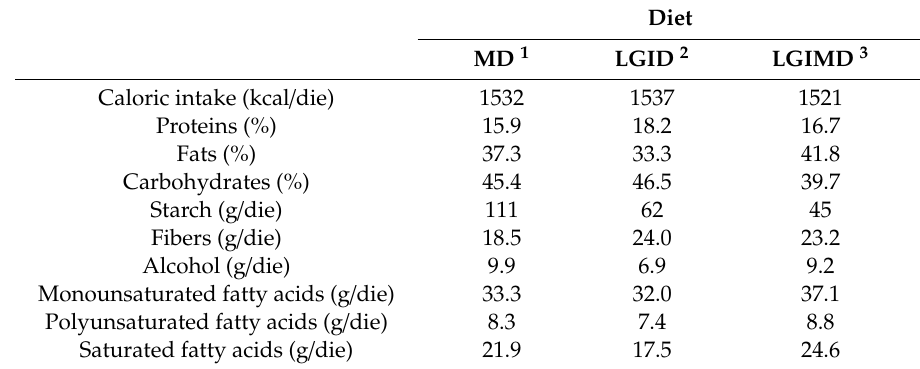
Table A1. Energy and nutrients intake in the Mediterranean Diet (MD) Low Glycemic Index Diet (LGID) and Low Glycemic Index Mediterranean Diet